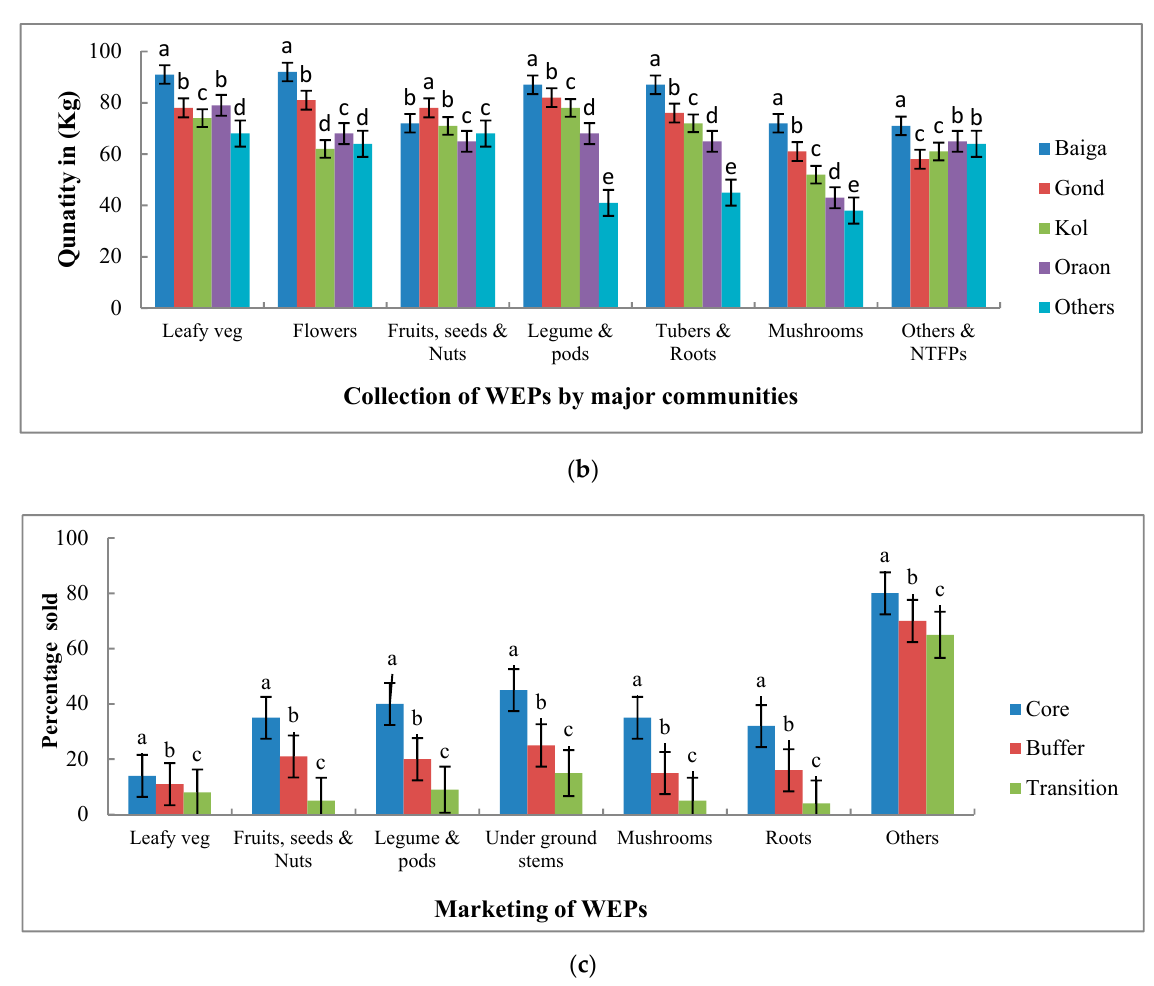
Figure 3. ( a ): Annual quantities of collection of WEPs by households in different zones of AABR, Central India. Different letters denoted on bars for each category of WEPs are statistically different at p ≤ 0.05, (N = 332; ±SEm of mean quantities). ( b ): Annual collection of WEPs by major communities of AABR, Central India. Different letters denoted on bars for each category of WEPs are statistically different at p ≤ 0.05, (N = 332; ±SEm of mean quantities). ( c ): Marketing (Yearly) of WEPs collected by households in different zones of AABR, Central India. Different letters denoted on bars for each category of WEPs are statistically different at p ≤ 0.05, (N = 332; ±SEm of percentages).